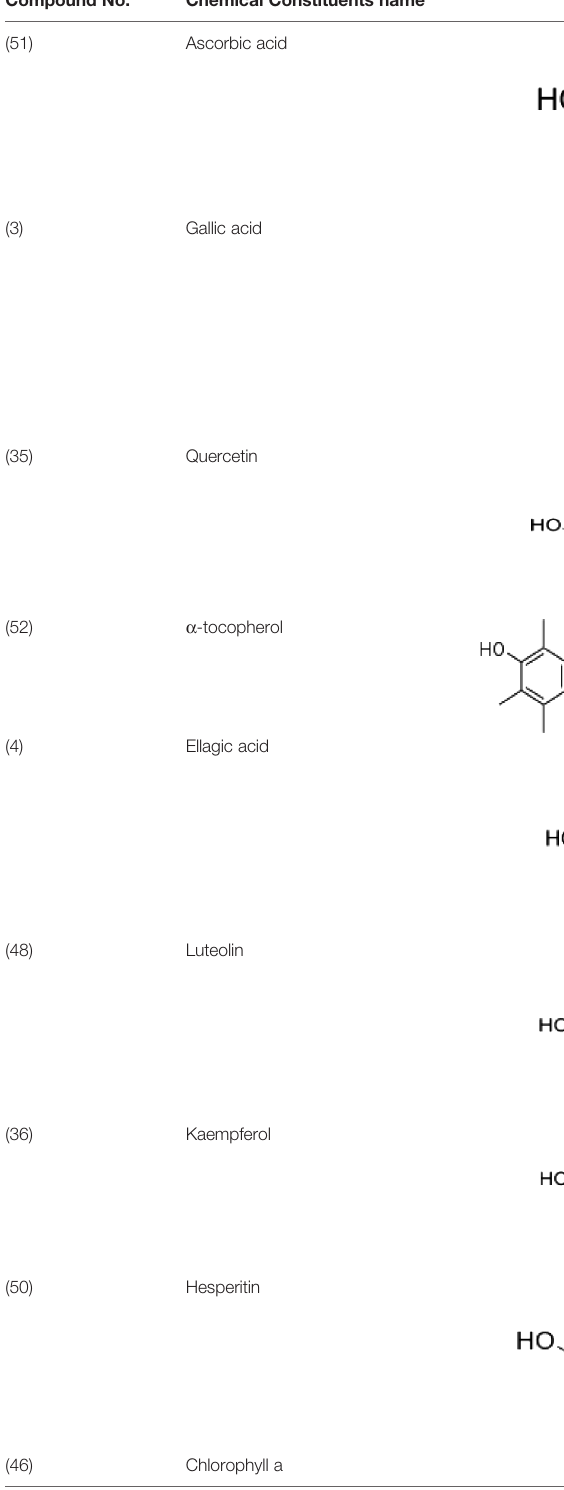
TABLE 2 | Chemical Constituents of T. ferdinandiana Exell. Compound